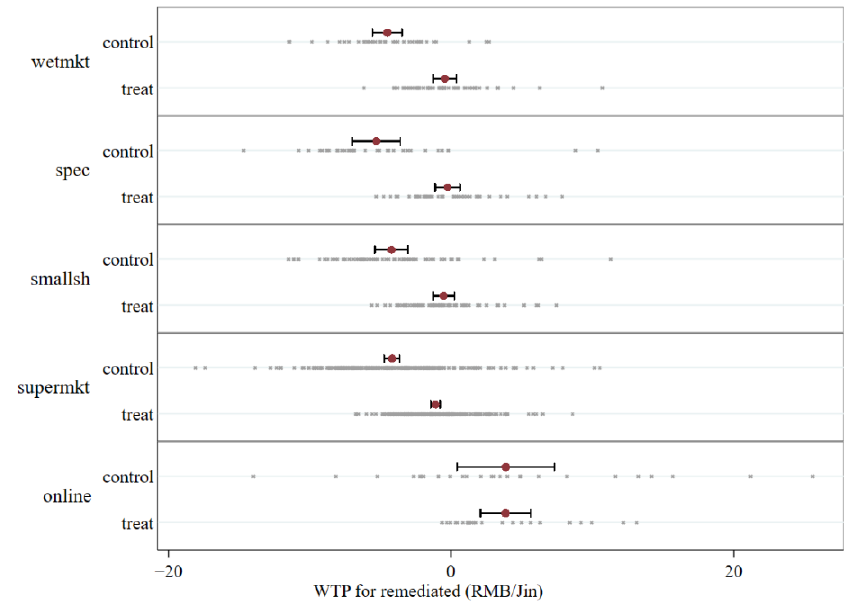
Figure 5. WTP for the remediated claim of different buying channels by treatment. Note: The red dot represents the mean WTP, the line represents 95% confidence interval, and a gray dot represents individual WTP.